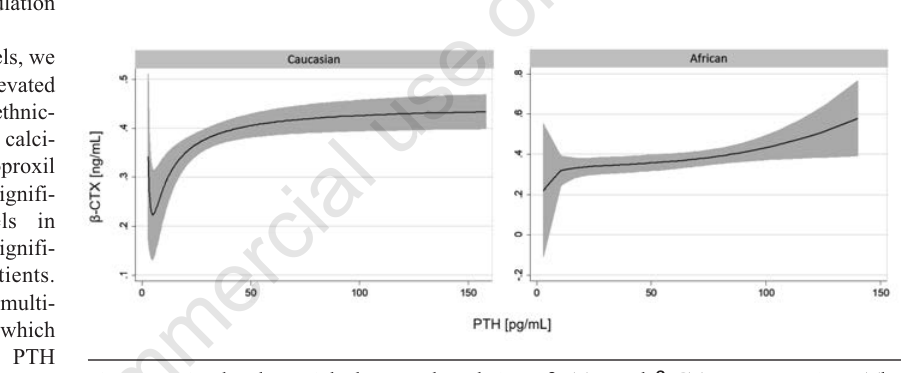
-CTX concentrations. The -CTX con- β β